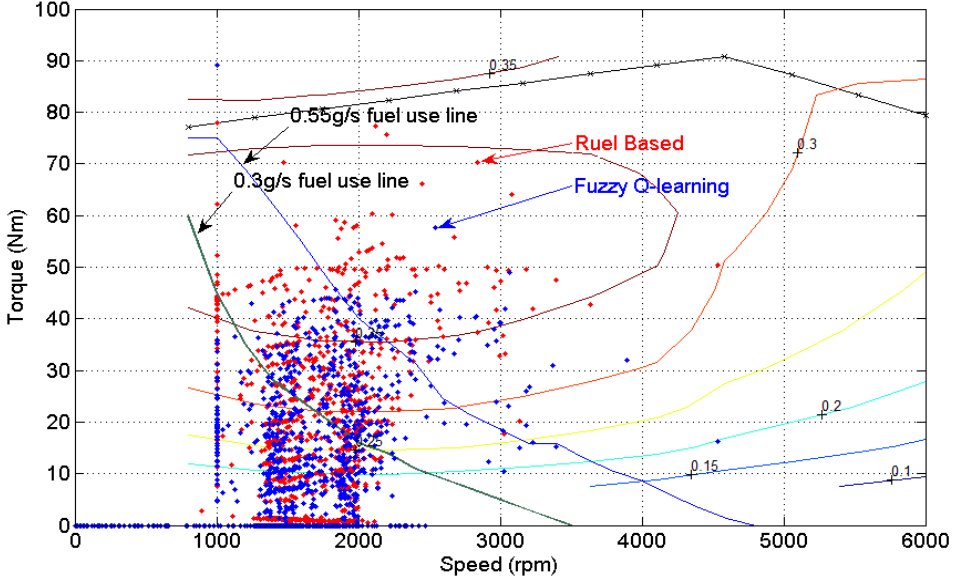
Figure 10. Engine operation point distribution under